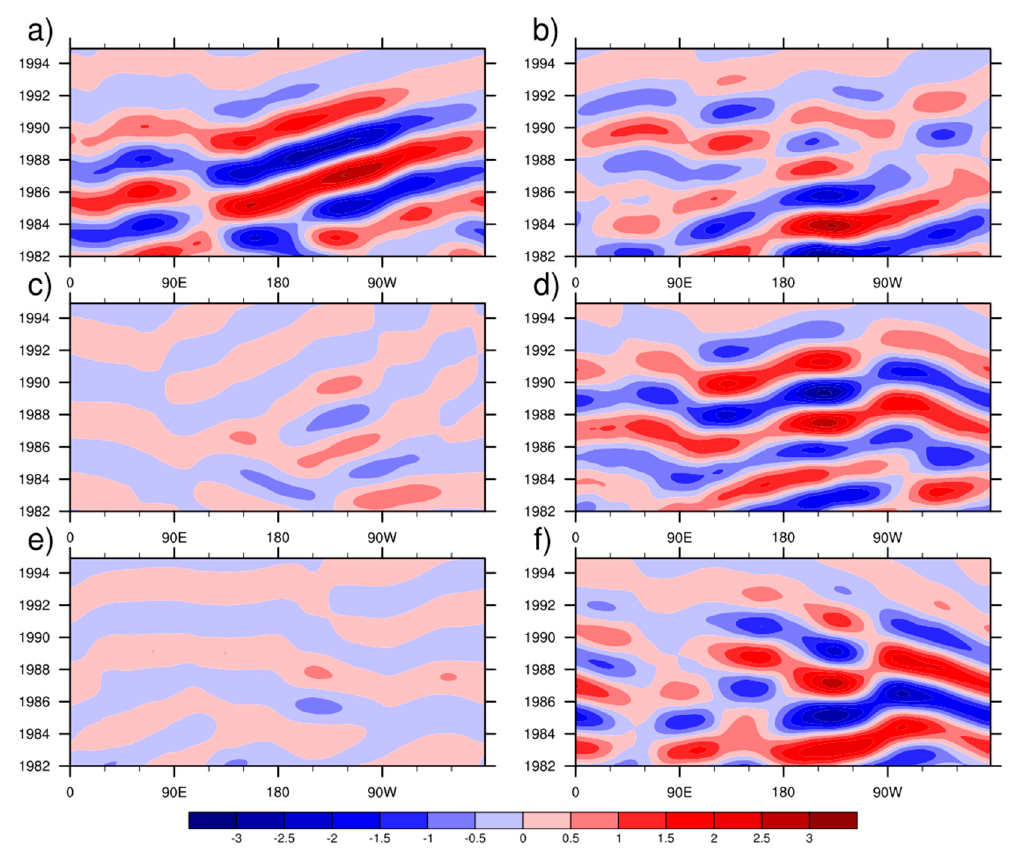
Figure 3. Time-longitude (Hovmöller) diagrams for SLP monthly anomalies from the ERA5 dataset and selected models (contours at 0.5 hPa interval). ( a ) ERA5 (as reference data); ( b ) FIO-ESM-2-0 model (highest S score); ( c ) CMIP5 ensemble mean; ( d ) CESM1-CAM5 model (highest EOF1 time series correction in CMIP5); ( e ) CMIP6 ensemble mean and ( f ) CanESM5 model (highest EOF1 time series correction in CMIP6).